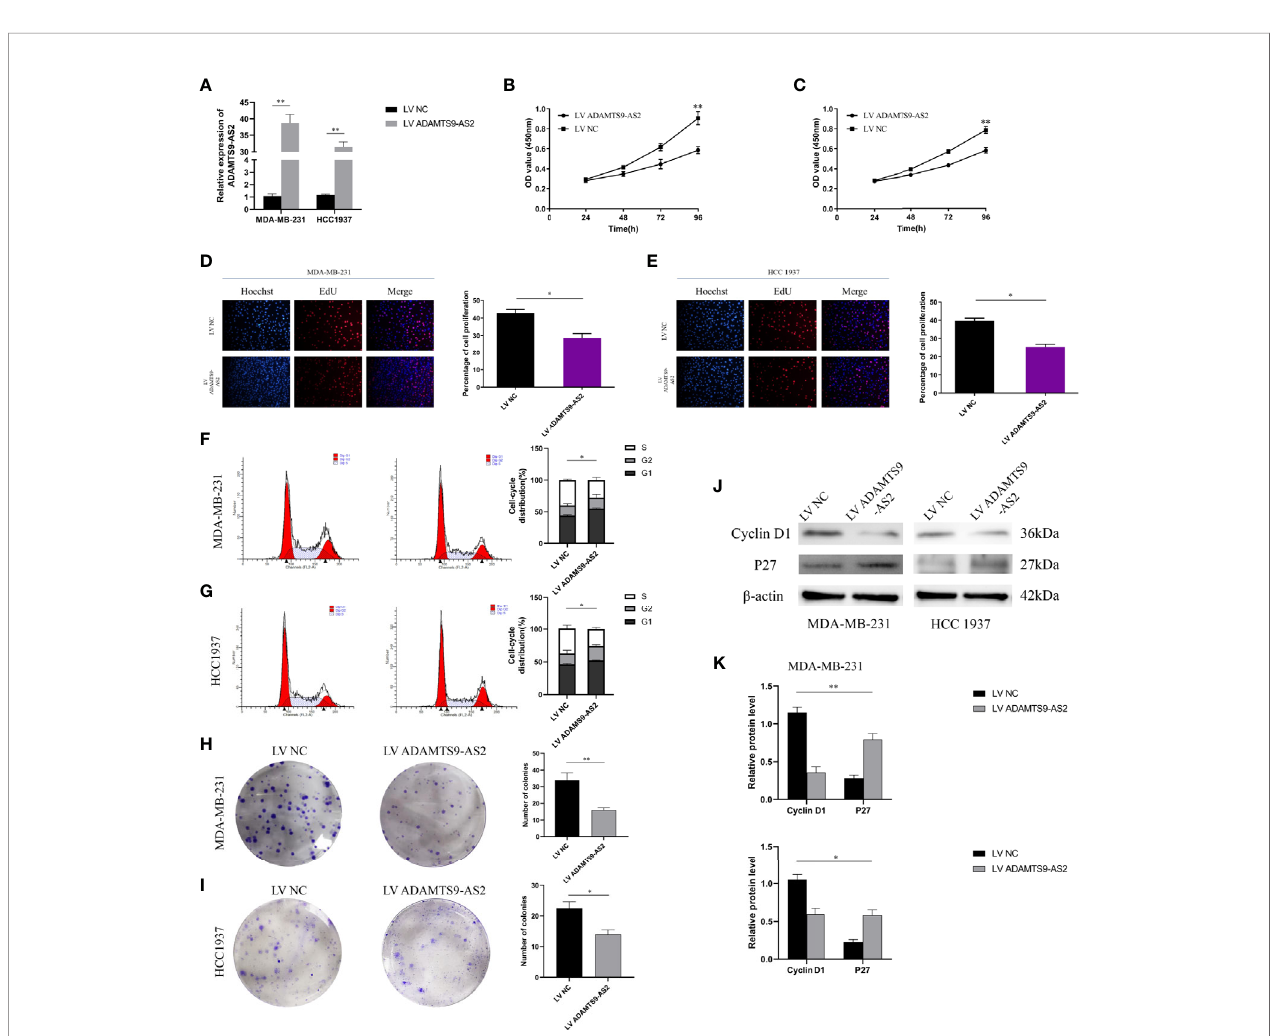
FIGURE 2 | ADAMTS9 ‐ AS2 suppresses TNBC cell proliferation. a: qRT-PCR analysis of LncRNA ADAMTS9-AS2 expression in TNBC cells transfected with ADAMTS9-AS2 overexpression vector or NC. (B, C) Growth curves of cells transfected with indicated vectors were evaluated by CCK8 assays. (D, E) EdU assays were conducted in cells after transfection with LV ADAMTS9-AS2 or LV NC. (F, G) The cell cycle progression was analyzed by fl ow cytometry after indicated transfected. (H, I) Colony formation assays were executed to detect the proliferation of TNBC cells transfected with indicated vectors. (J, K) Western blot was used to detect the in fl uence of ADAMTS9-AS2 on cell cycle markers. *P < 0.05, **P <